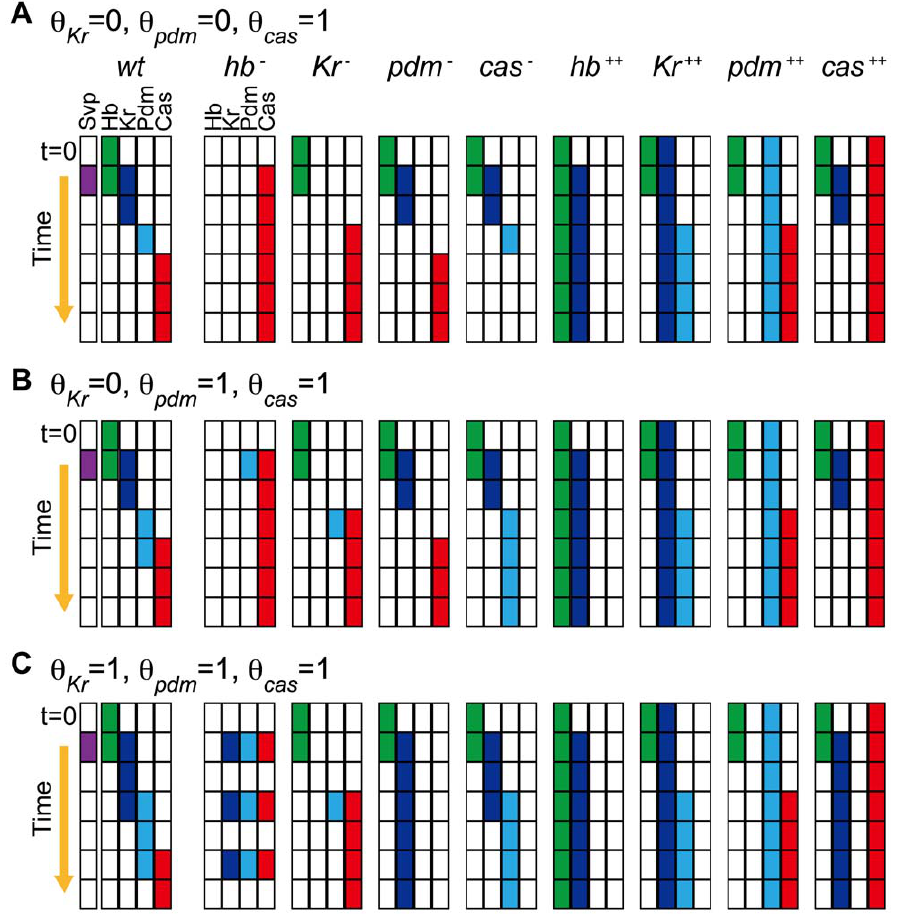
Figure 2. Reconstructed Drosophila network cannot reproduce the experimentally reported expression profiles. Sequential gene expression of reconstructed Drosophila network is simulated using Boolean model. The grids filled with colors represent ON states of the genes. The dynamics could be different depending on the choice of the default expression states f h i g . ( A ) h Kr ~ 0, h pdm ~ 0, and h cas ~ 1 ; ( B ) h Kr ~ 0, h pdm ~ 1, and h cas ~ 1 ; and ( C ) h Kr ~ 1, h pdm ~ 1, and h cas ~ 1 .